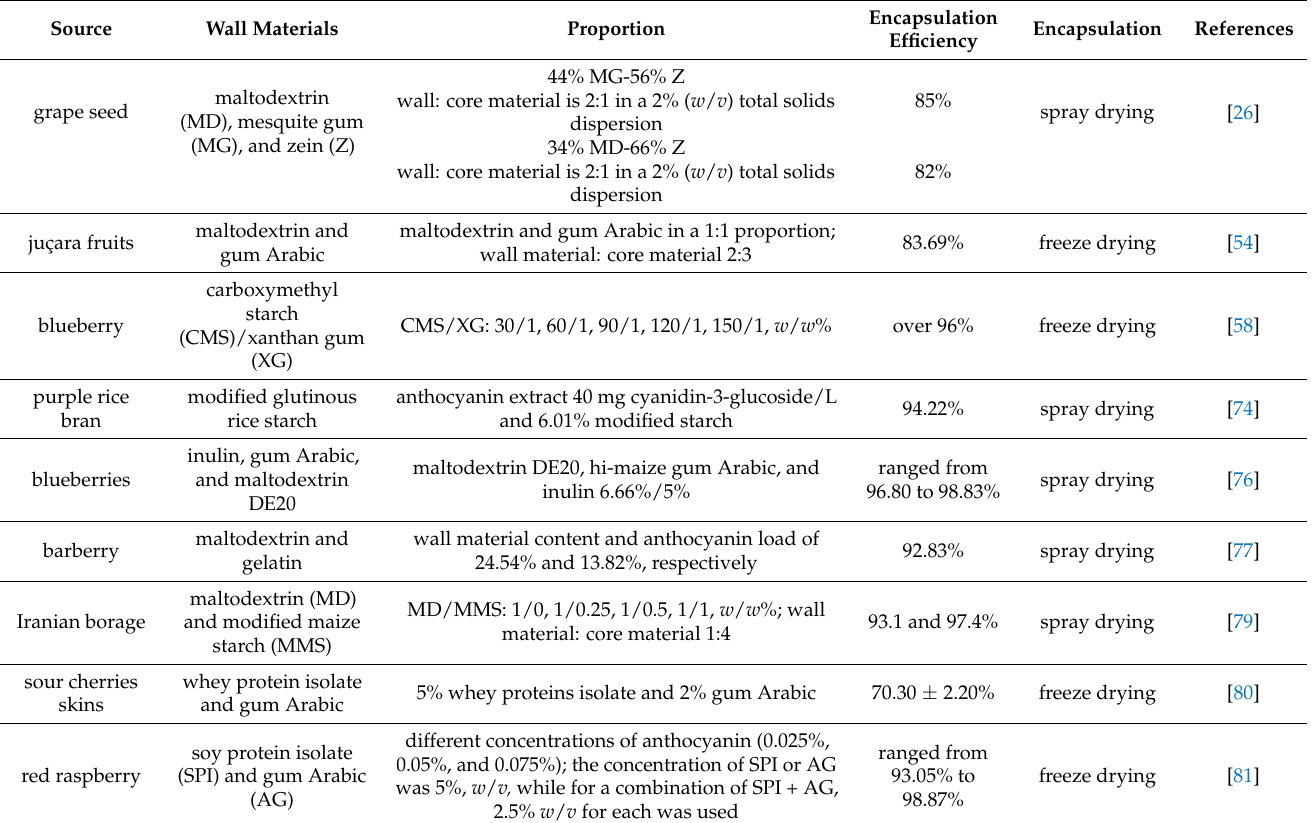
Table 3. Study on the microencapsulation of